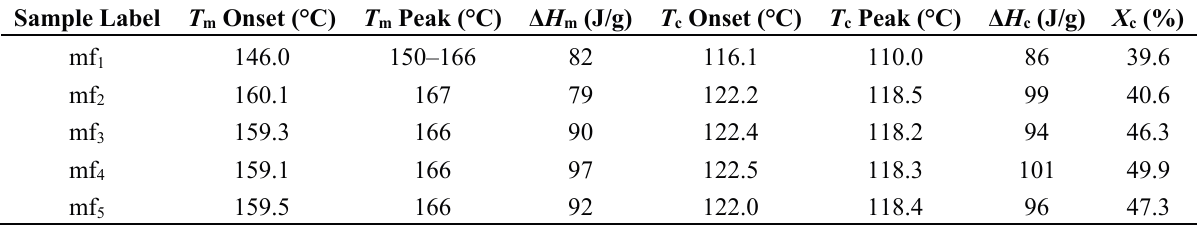
Table 4. Thermal properties of nonwovens studied on this